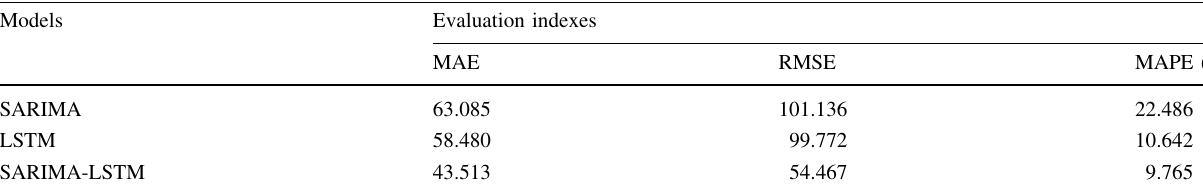
Table 4 Effect evaluation of different prediction models Models